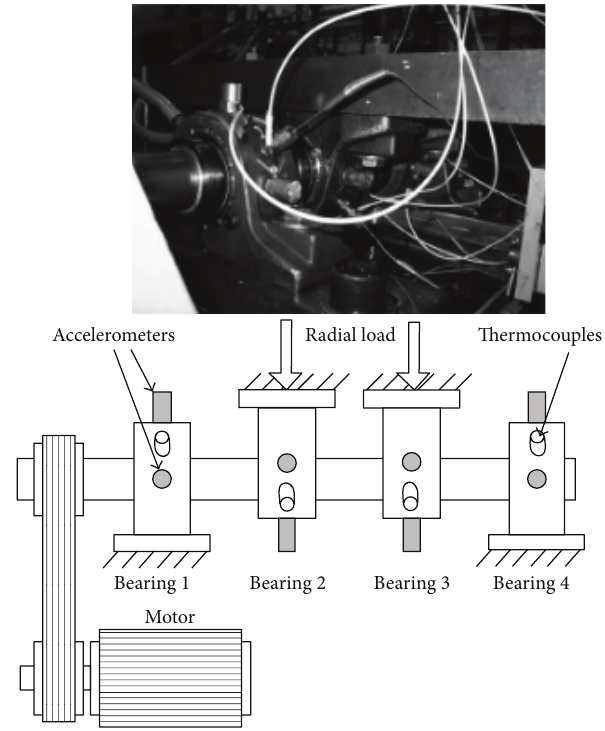
Figure 5: Experimental bearing test rig.